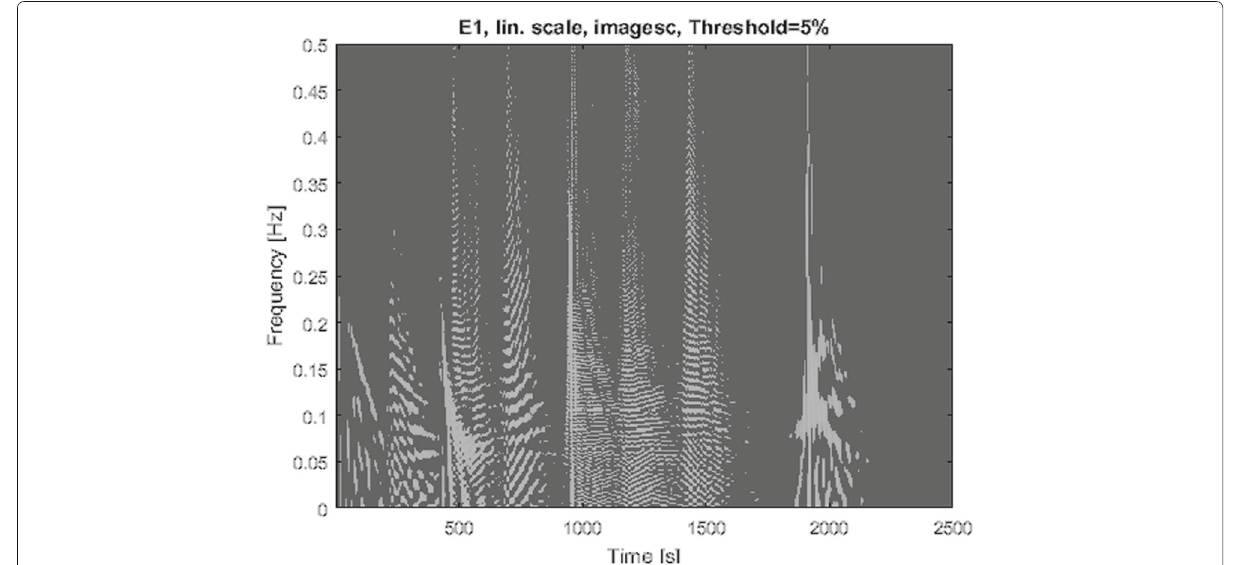
Fig. 8 Pseudo Wigner-Ville representation (time-frequency) of PCG